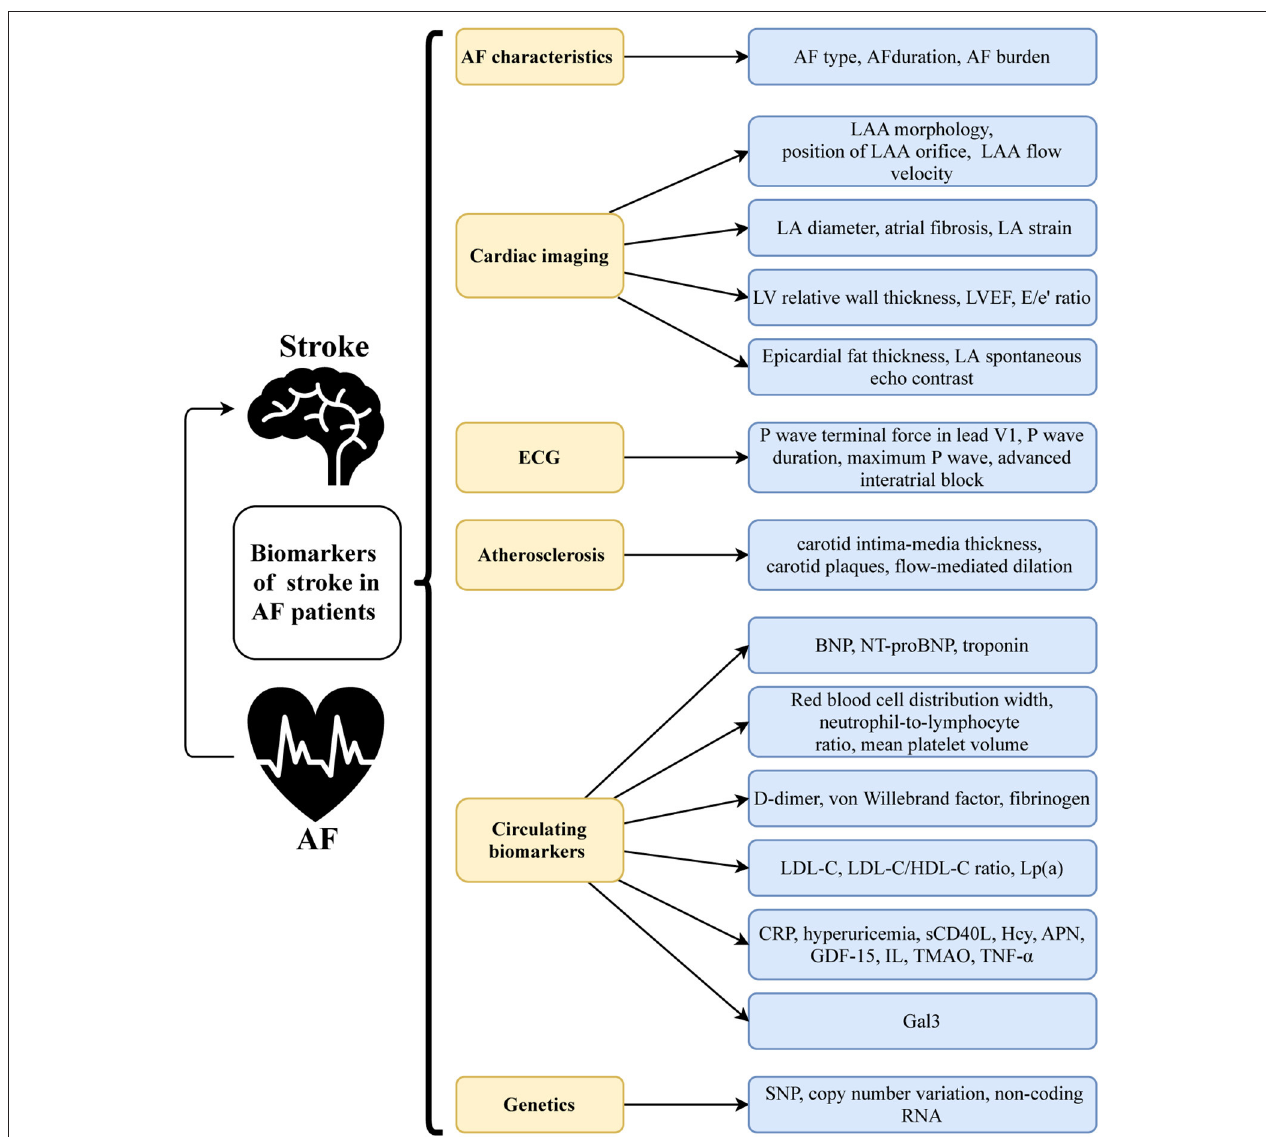
FIGURE 1 | Classification of biomarkers in AF-related